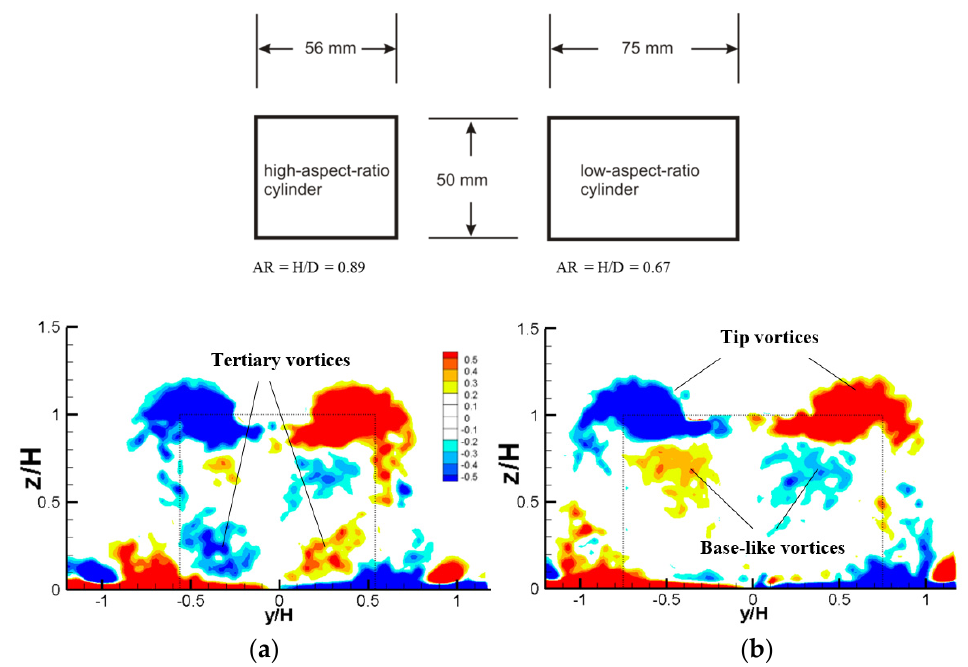
Figure 1. Isocontours of dimensionless, time-averaged streamwise vorticity, ω x * = ω x H / U , in the wake of circular cylinders (H = 50 mm) [9] in x / H = 1.0. ( a ) AR = 0.89 and ( b ) AR = 0.67. Red shades represent positive counter-clockwise vorticity, blue shades represent negative clockwise rotation.